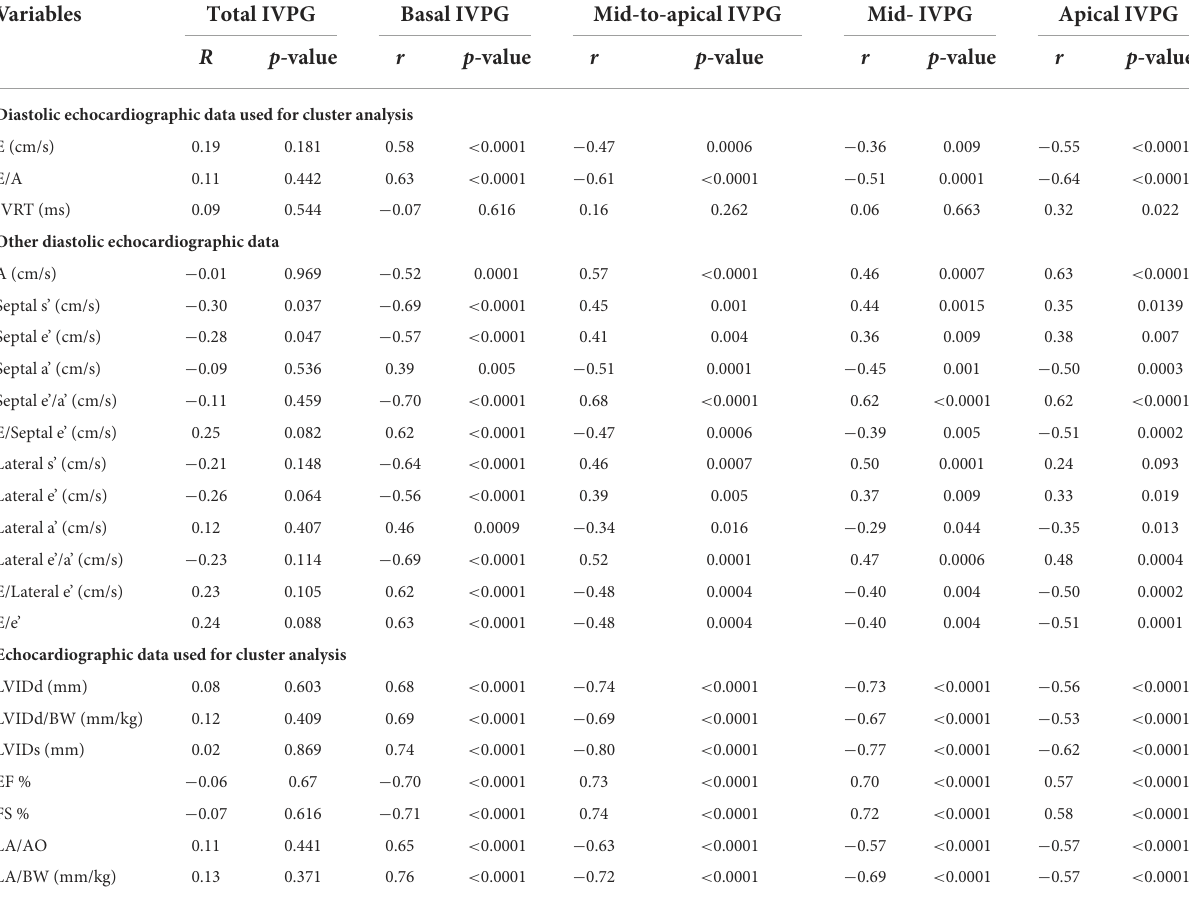
TABLE 3 Correlation between IVPG and conventional echocardiographic